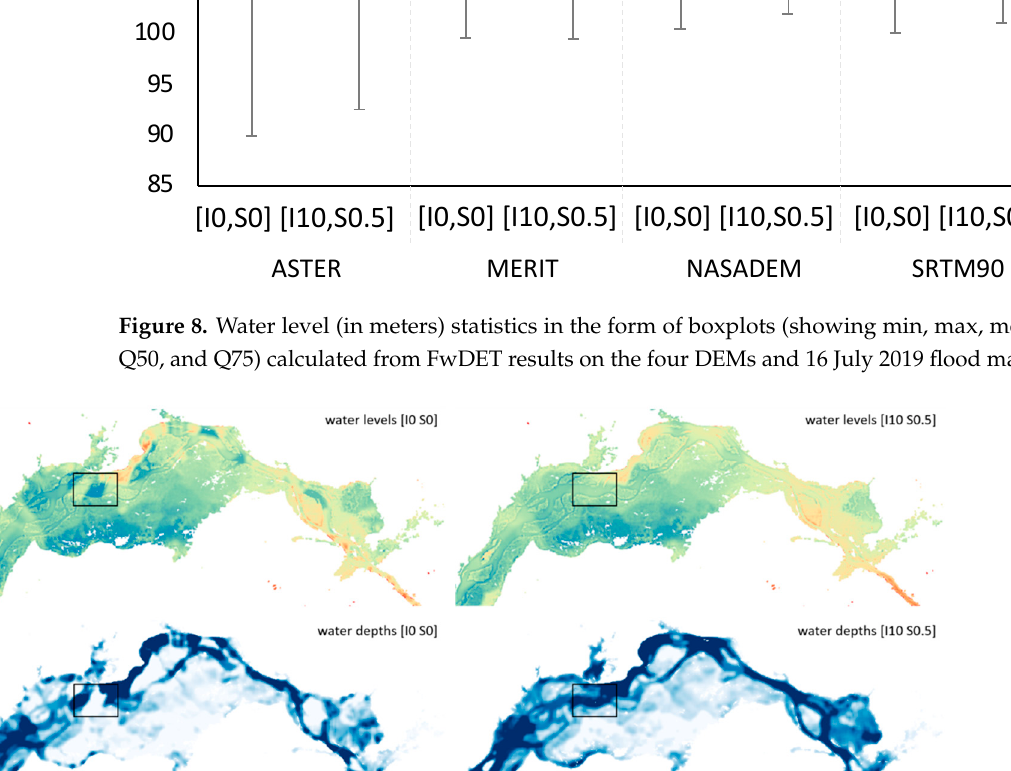
Figure 8. Water level (in meters) statistics in the form of boxplots (showing min, max, mean, Q25, Q50, and Q75) calculated from FwDET results on the four DEMs and 16 July 2019 flood map.